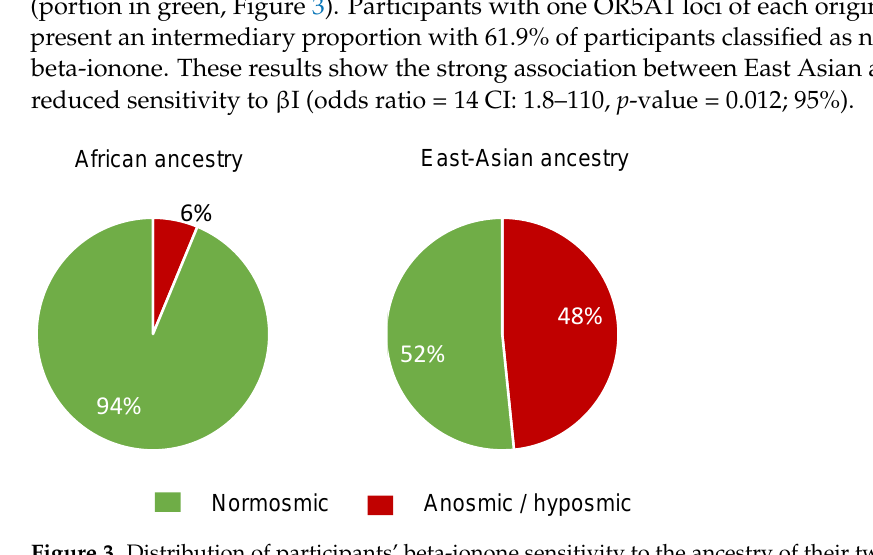
Figure 3. Distribution of participants’ beta-ionone sensitivity to the ancestry of their two OR5A1 loci. Only individuals with homogenous ancestry are represented, Individuals with dual ancestry (one OR5A1 locus from each ancestry) are excluded from this representation.